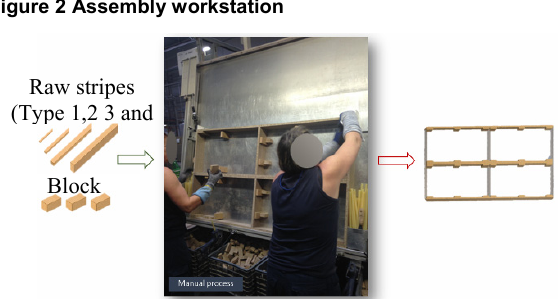
Figure 2 Assembly workstation